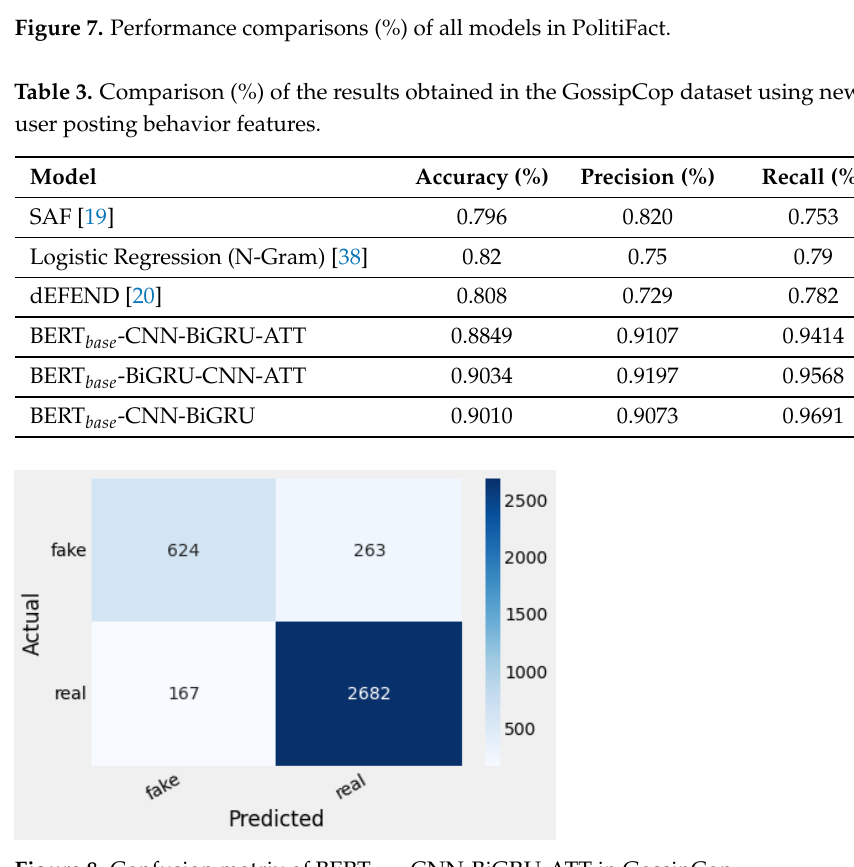
Figure 8. Confusion matrix of BERT base -CNN-BiGRU-ATT in